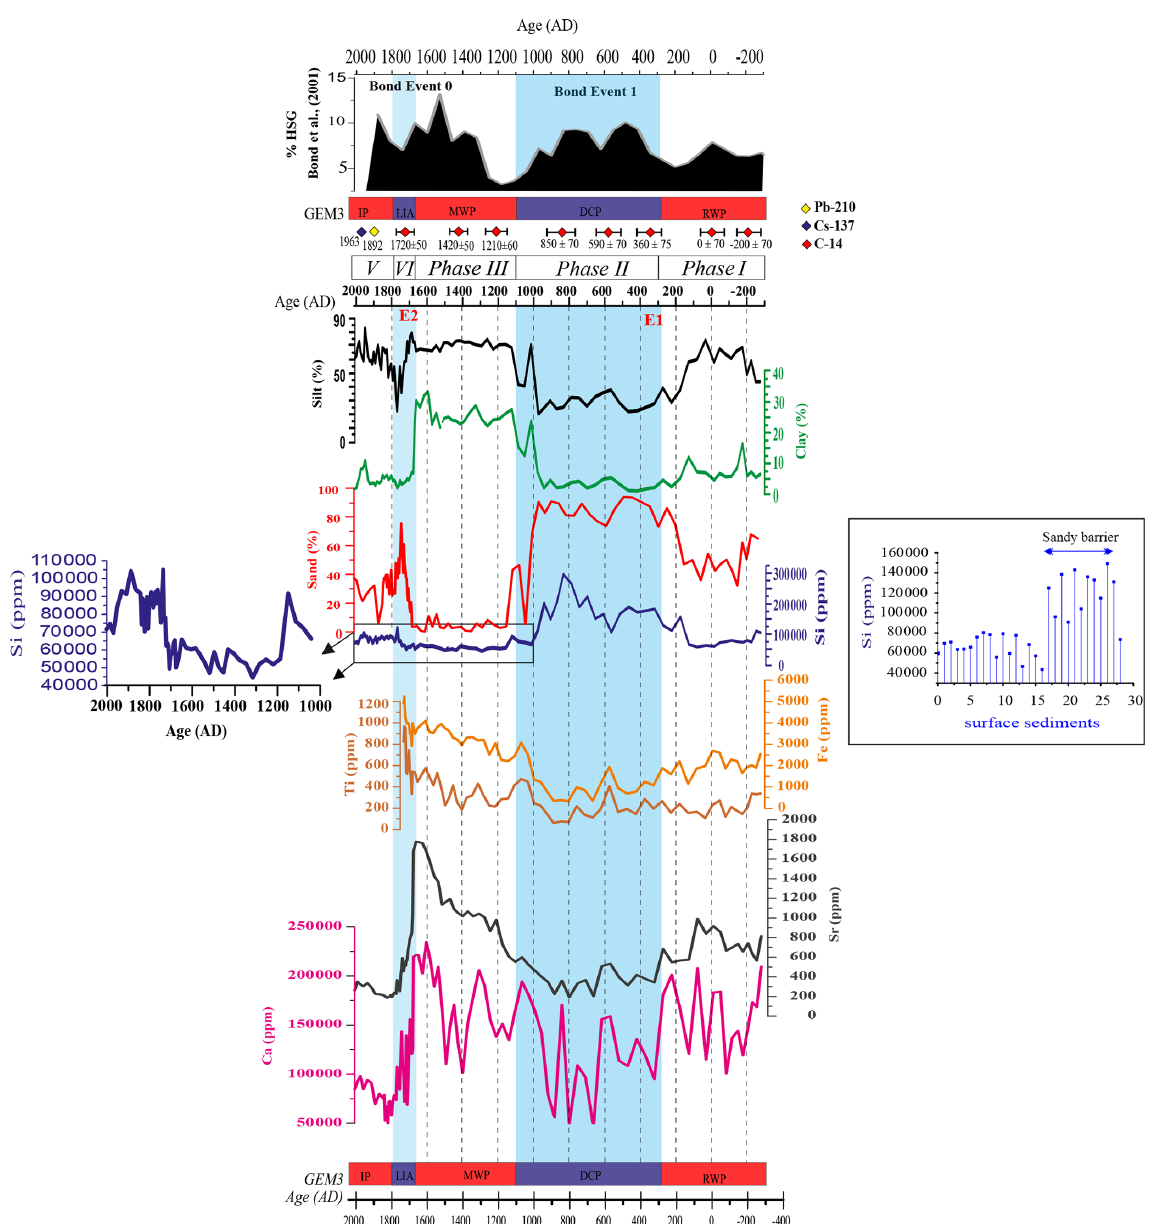
Figure 9. Evolution of grain size population compared to the results obtained from the XRF records (iron, calcium, silicon, titanium, and strontium), vs.